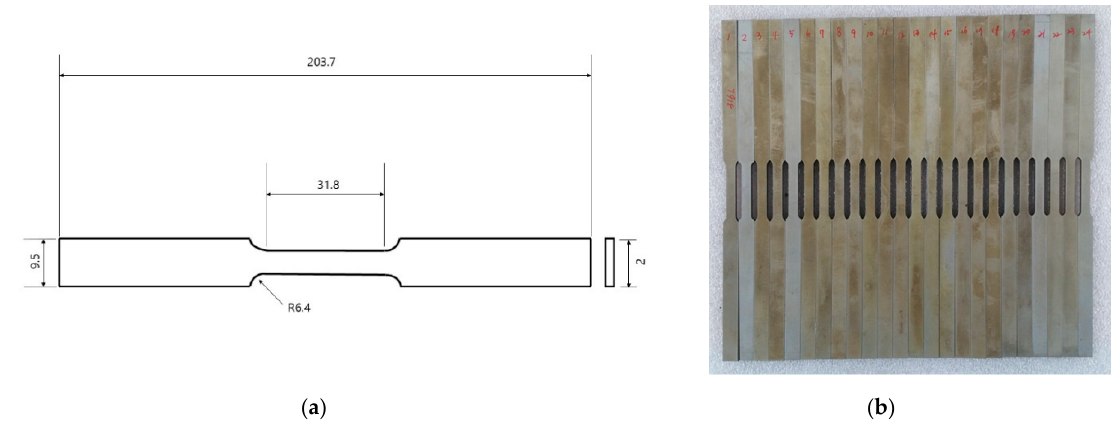
Figure 2. ( a ) Dimensions of test specimen(mm); ( b ) Prepared test specimens.